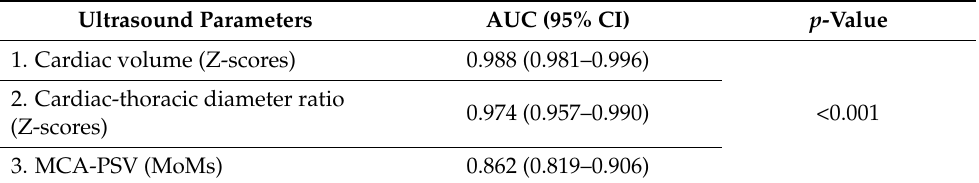
Table 3. Diagnostic indices of cardiac volume (CV), cardiac-thoracic diameter ratio (CTR) and MCA-PSV in predicting fetal Hb Bart’s disease.